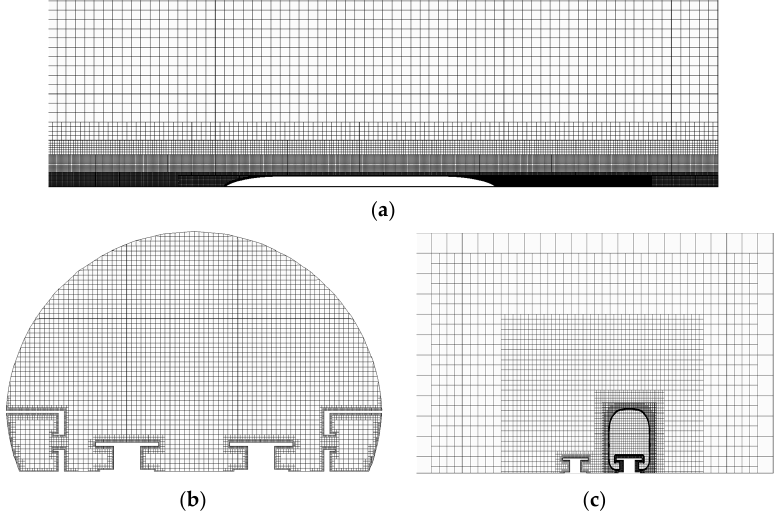
Figure 5. Grid generation details. ( a ) Longitudinal section of train; ( b ) Internal tunnel cross section; ( c ) Cross section of train.